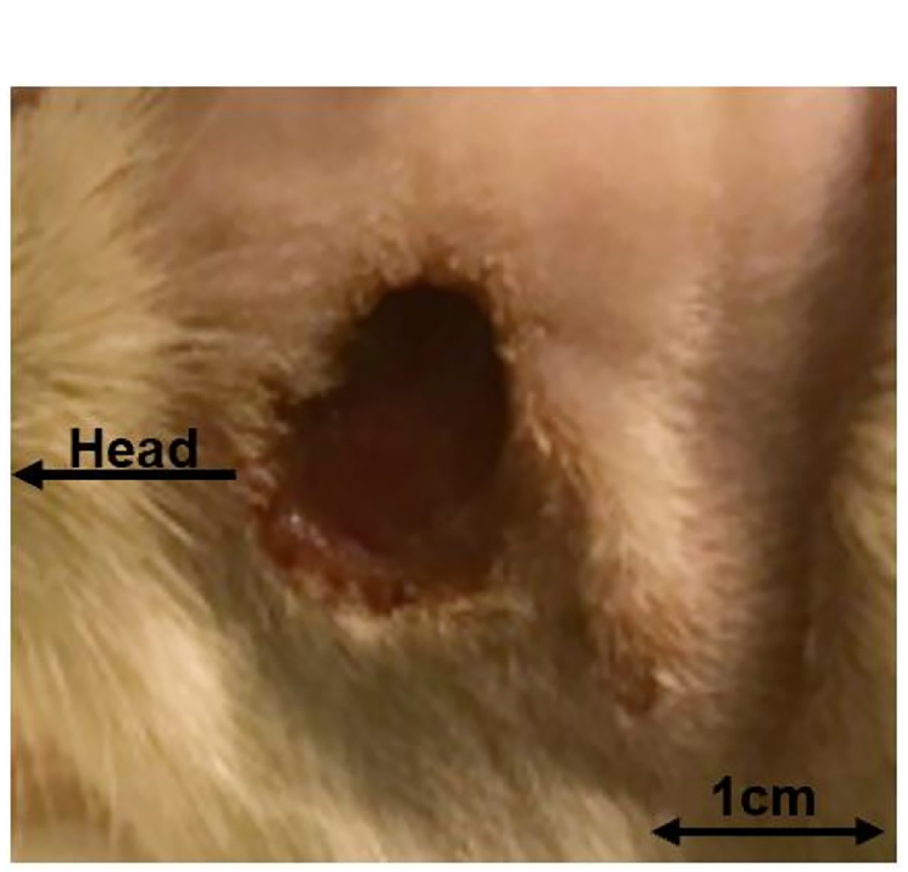
Fig 5. Skin affection. Skin affection of one animal in group CCH9 after 48 hours after injection of 0.9 mg/ml CCH.